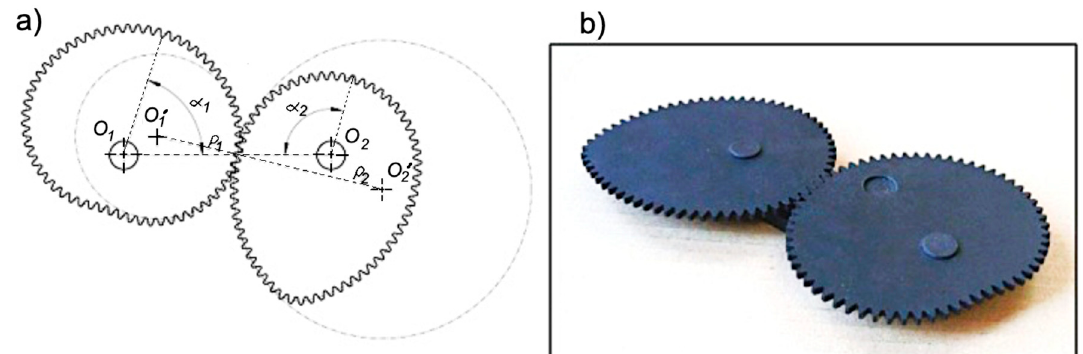
Figure 14. Evaluation of a tooth’s form.